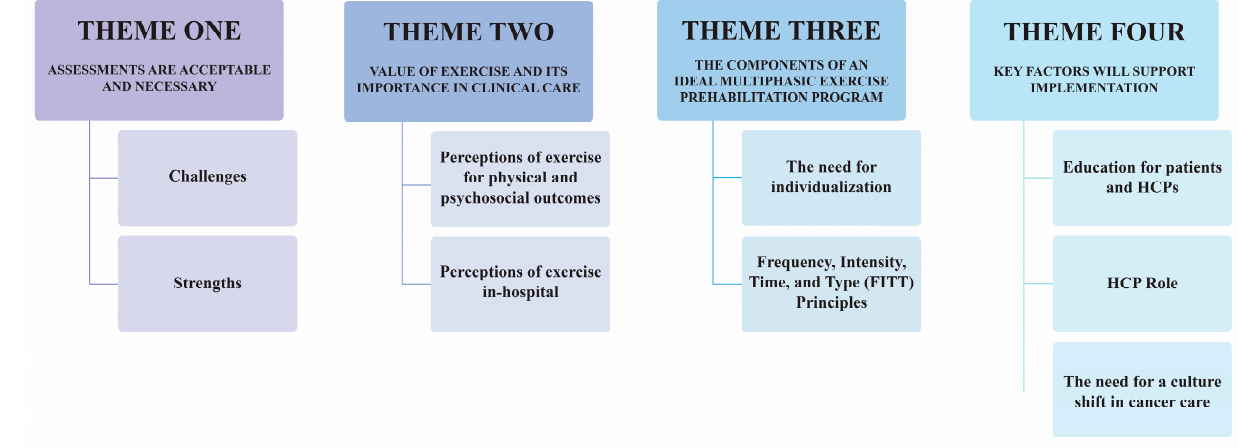
Figure 1. Main themes and sub-themes from interviews.